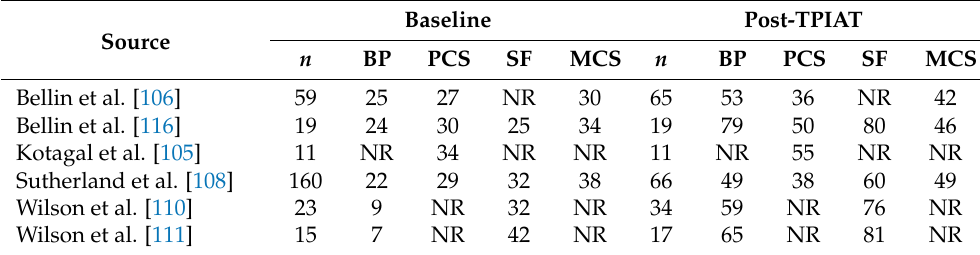
Table 1. Quality of life changes in TPIAT patients measured by SF-36